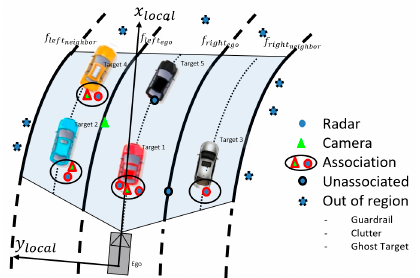
Figure 5. Multi-object data association within region of interest.